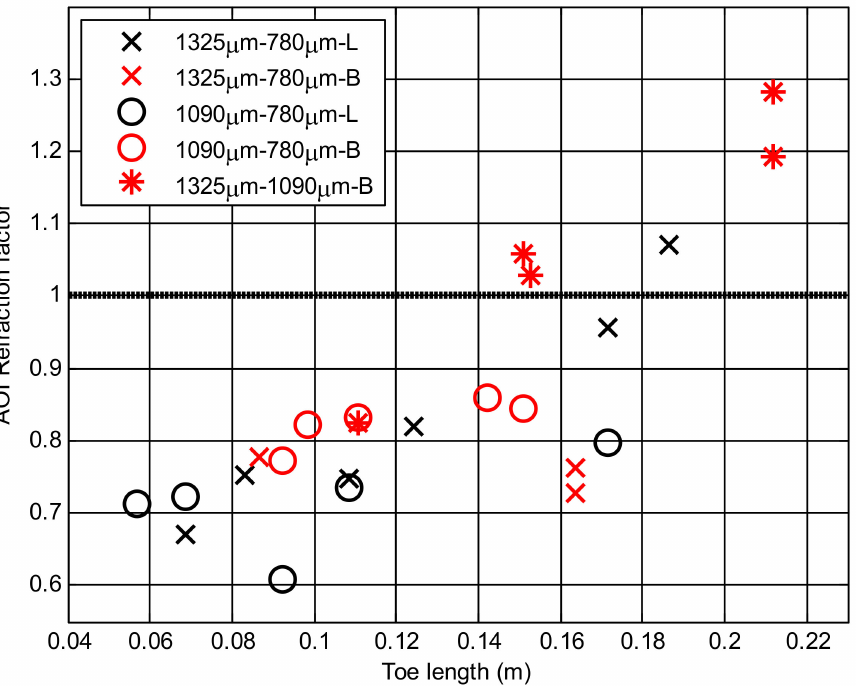
Figure 13. Saltwater–freshwater interface refraction across permeability boundaries for layered (black) and blocked (red) cases at corresponding TL